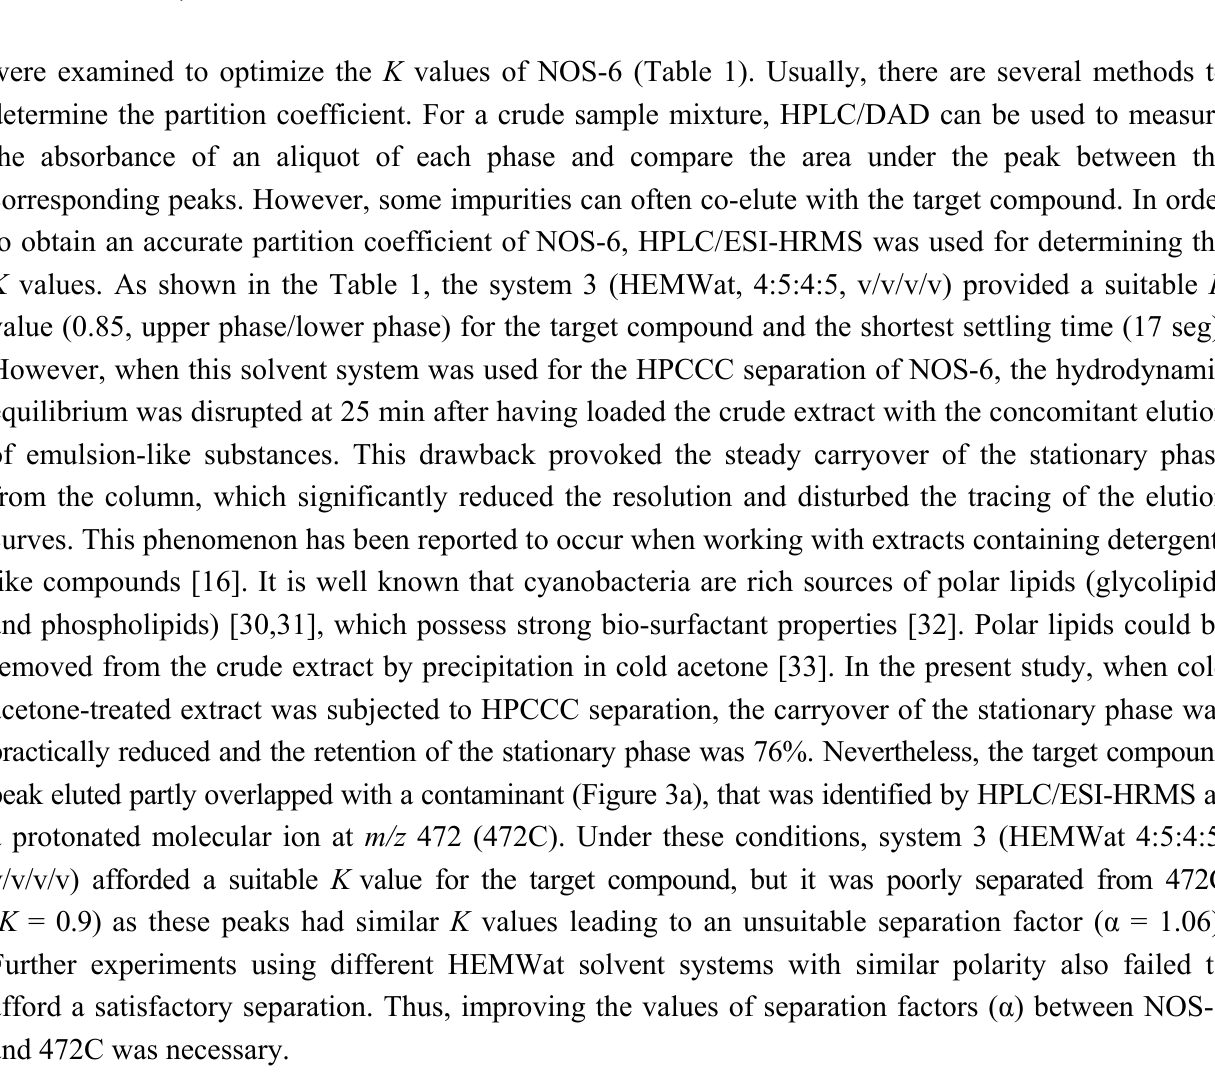
Table 1. The partition coefficient ( K ) of NOS-6 in different two-phase systems and the settling times. System no. Composition